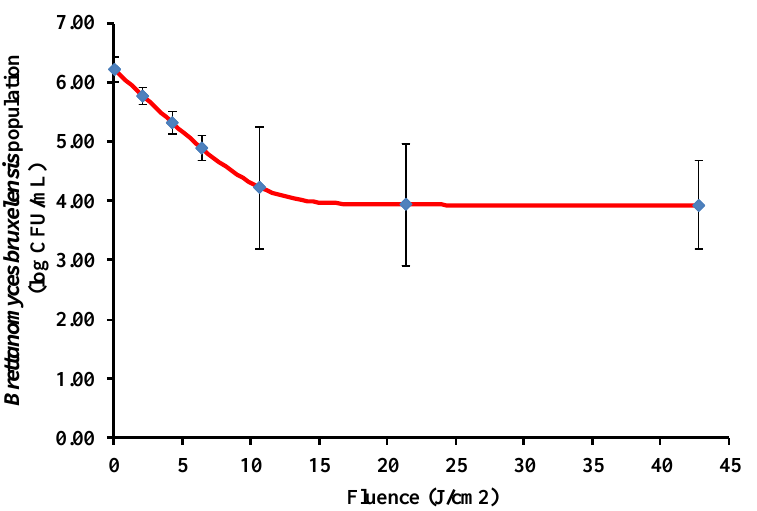
Figure 1. Inactivation of Brettanomyces bruxellensis in white wine by pulsed light. The line shows the fitting of the Geeraerd model including the tail effect.